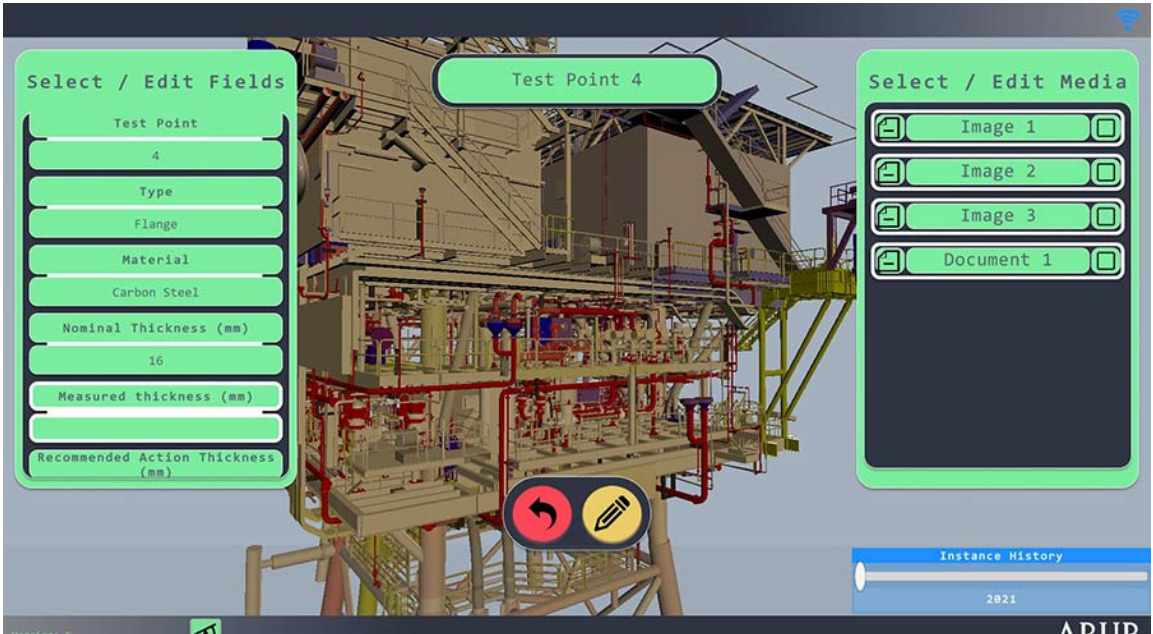
Figure 10. Typical integrity management application showing an offshore platform being inspected for the piping wall thickness using an in-house software by Arup. (Permission to use image was obtained from Cameron Dunn and Will Cavendish of Arup. Image Courtesy: Arup. Source: [127]).